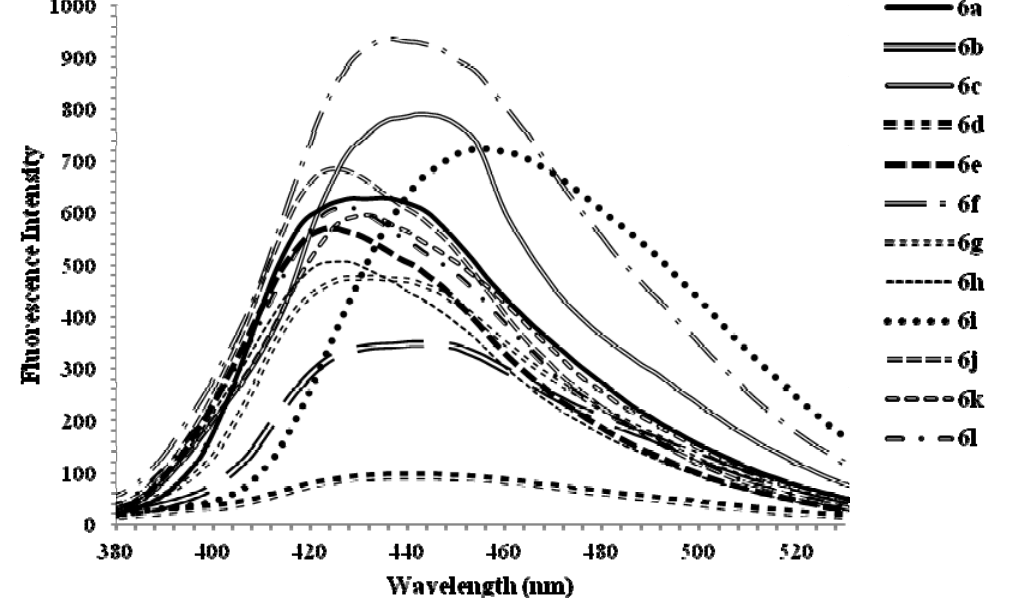
Figure 2. The fluorescence emission spectra of 6a – l (excitation wavelength λ in CHCl (2.0 × 10 − 7 mol/L) at 3